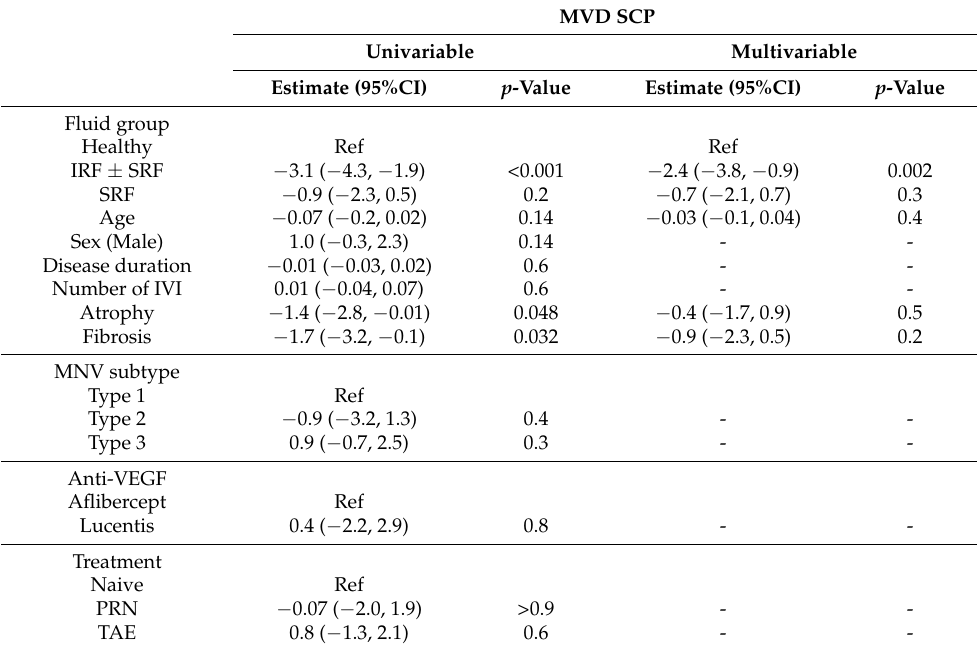
Table 3. Mean vascular density (MVD) in the superficial capillary plexus (SCP) according to different factors in the univariate and multivariate